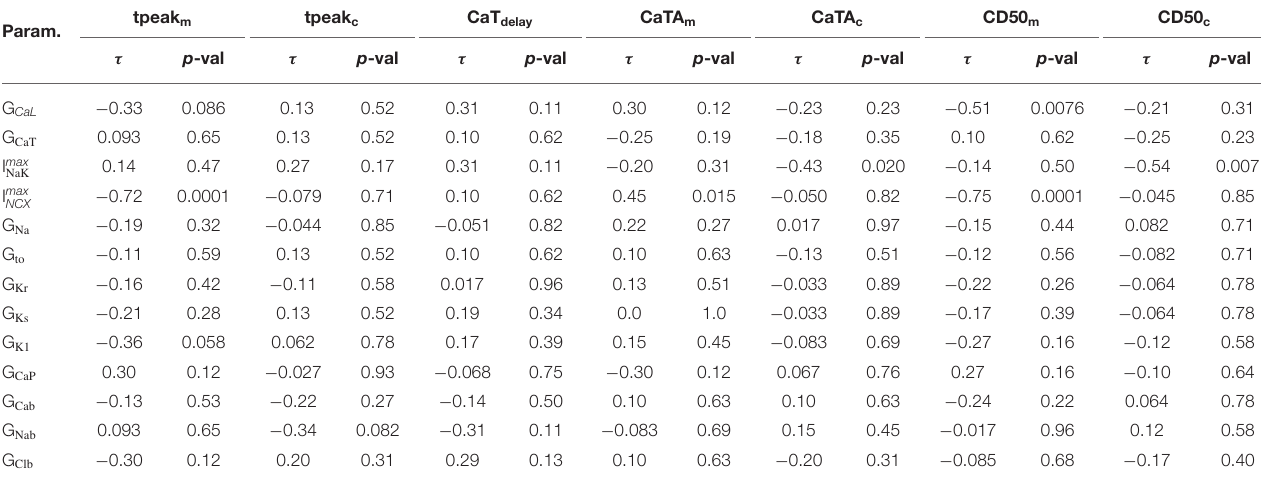
TABLE 5 | Kendall’s τ and corresponding p -values of the correlations between maximum conductances and CaT m and CaT c properties. Param.